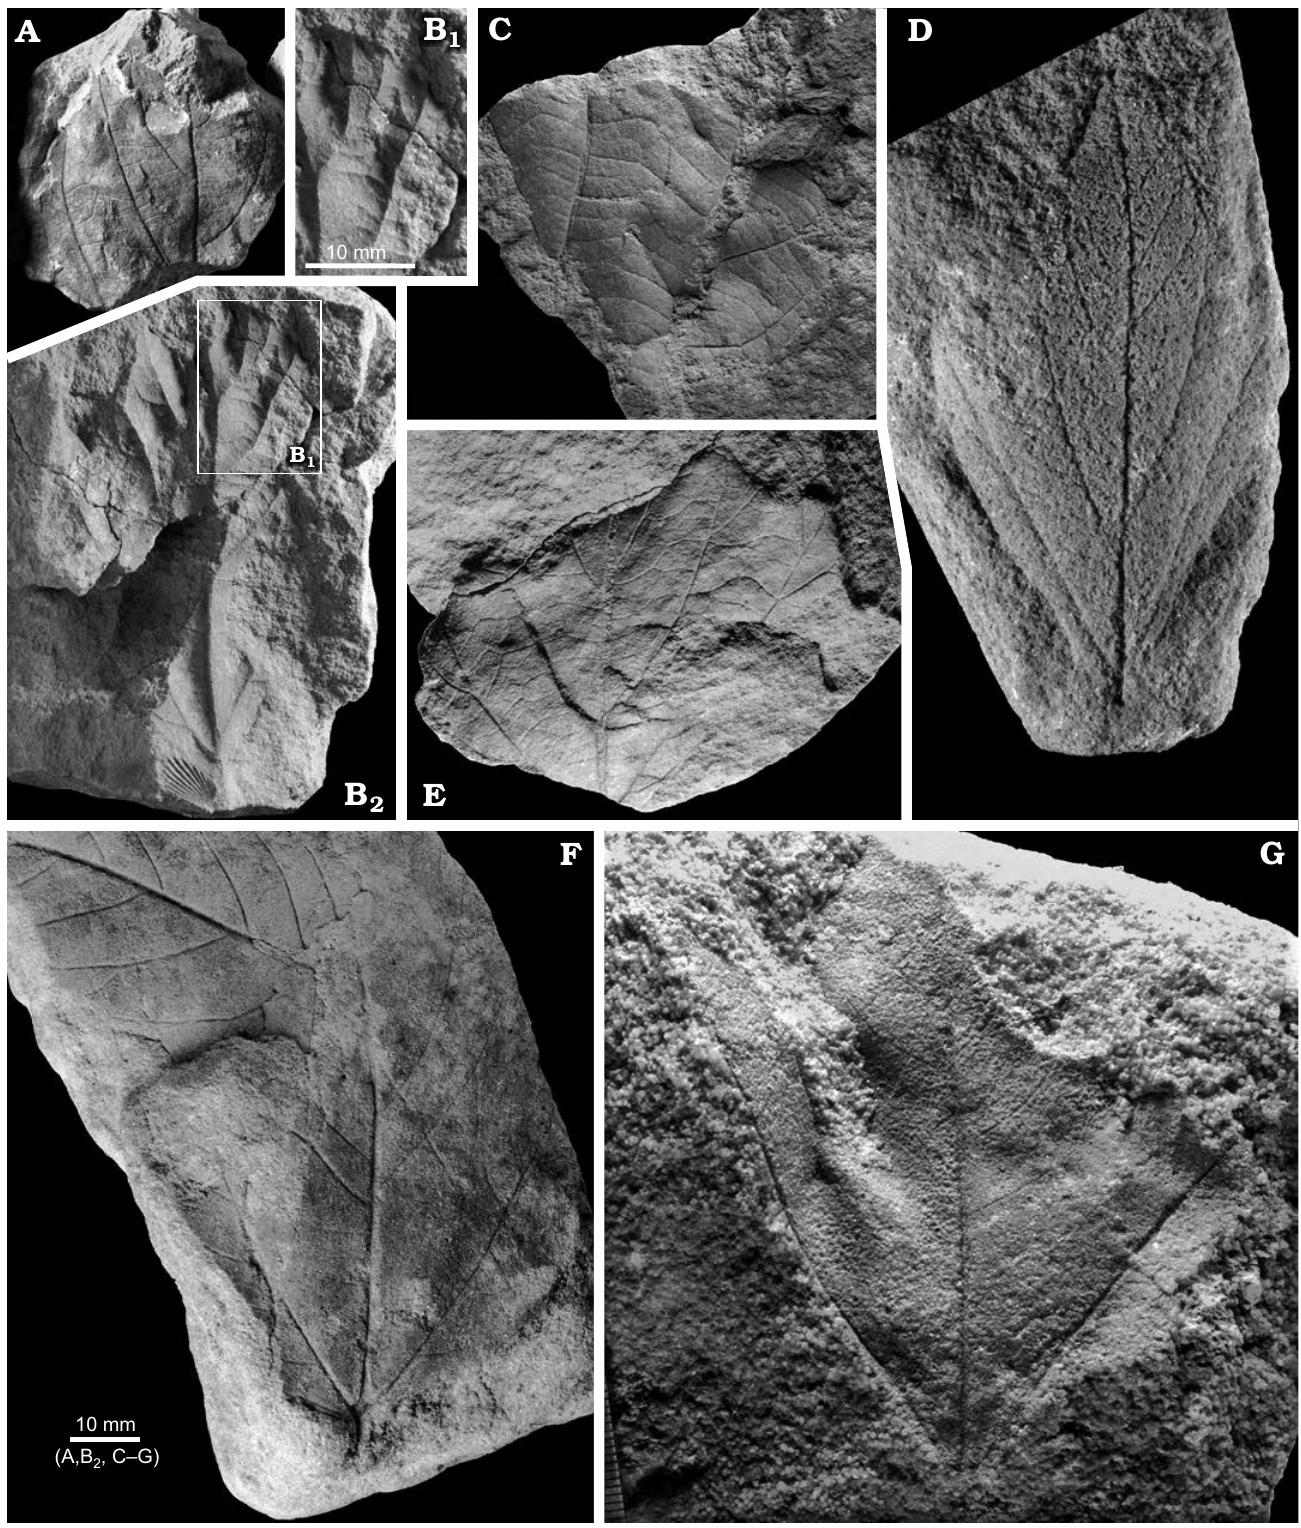
Fig. 13. Representatives of the platanoid Ettingshausenia from the North Sudetic Basin, Lower Silesia, Poland. A – C , E . Ettingshausenia cf. superstes (Velenovský, 1882) Kvaček and Halamski in Halamski and Kvaček, 2015, Assemblage 2 (Coniacian). A . Leaf fragment MB.Pb.2008/336,